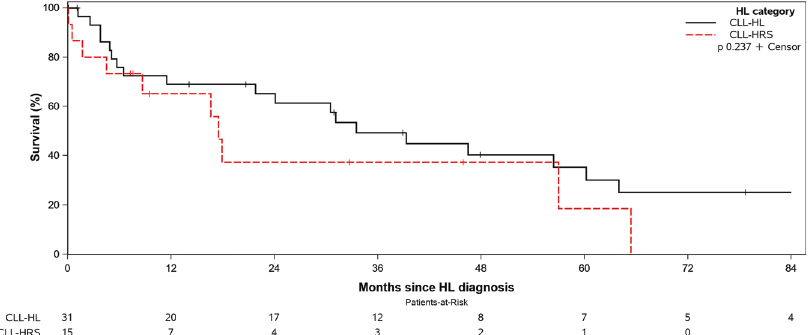
Fig. 3 Overall Survival of all patients in the study, according to a diagnosis of CLL with Reed – Sternberg-like cells (CLL-HRS) and CLL-Hodgkin lymphoma (CLL-HL).